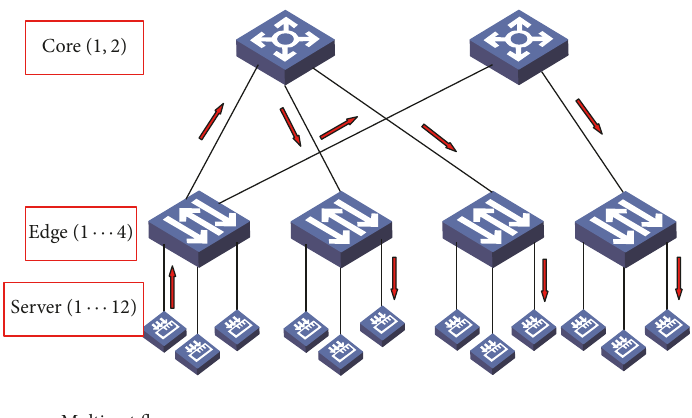
Figure 4: The multicast